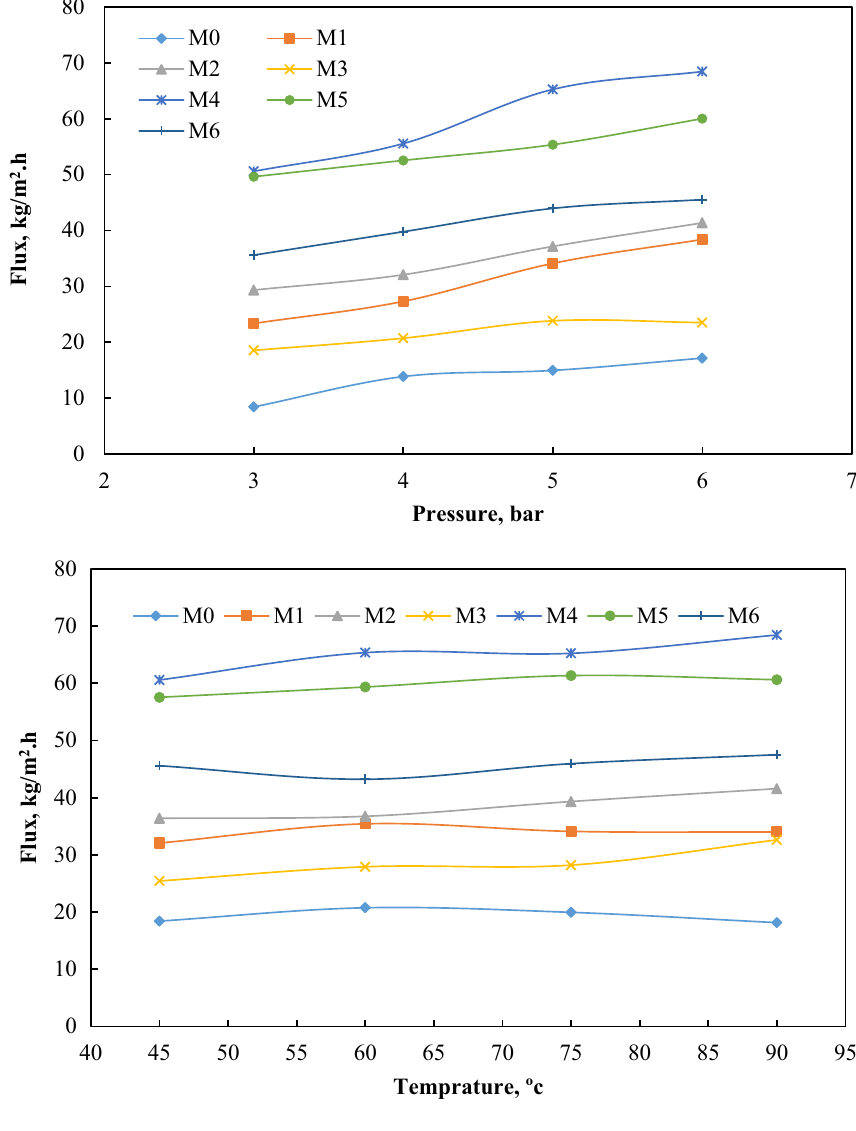
Fig. 3 Cross-sectional SEM images of the fabricated mem-